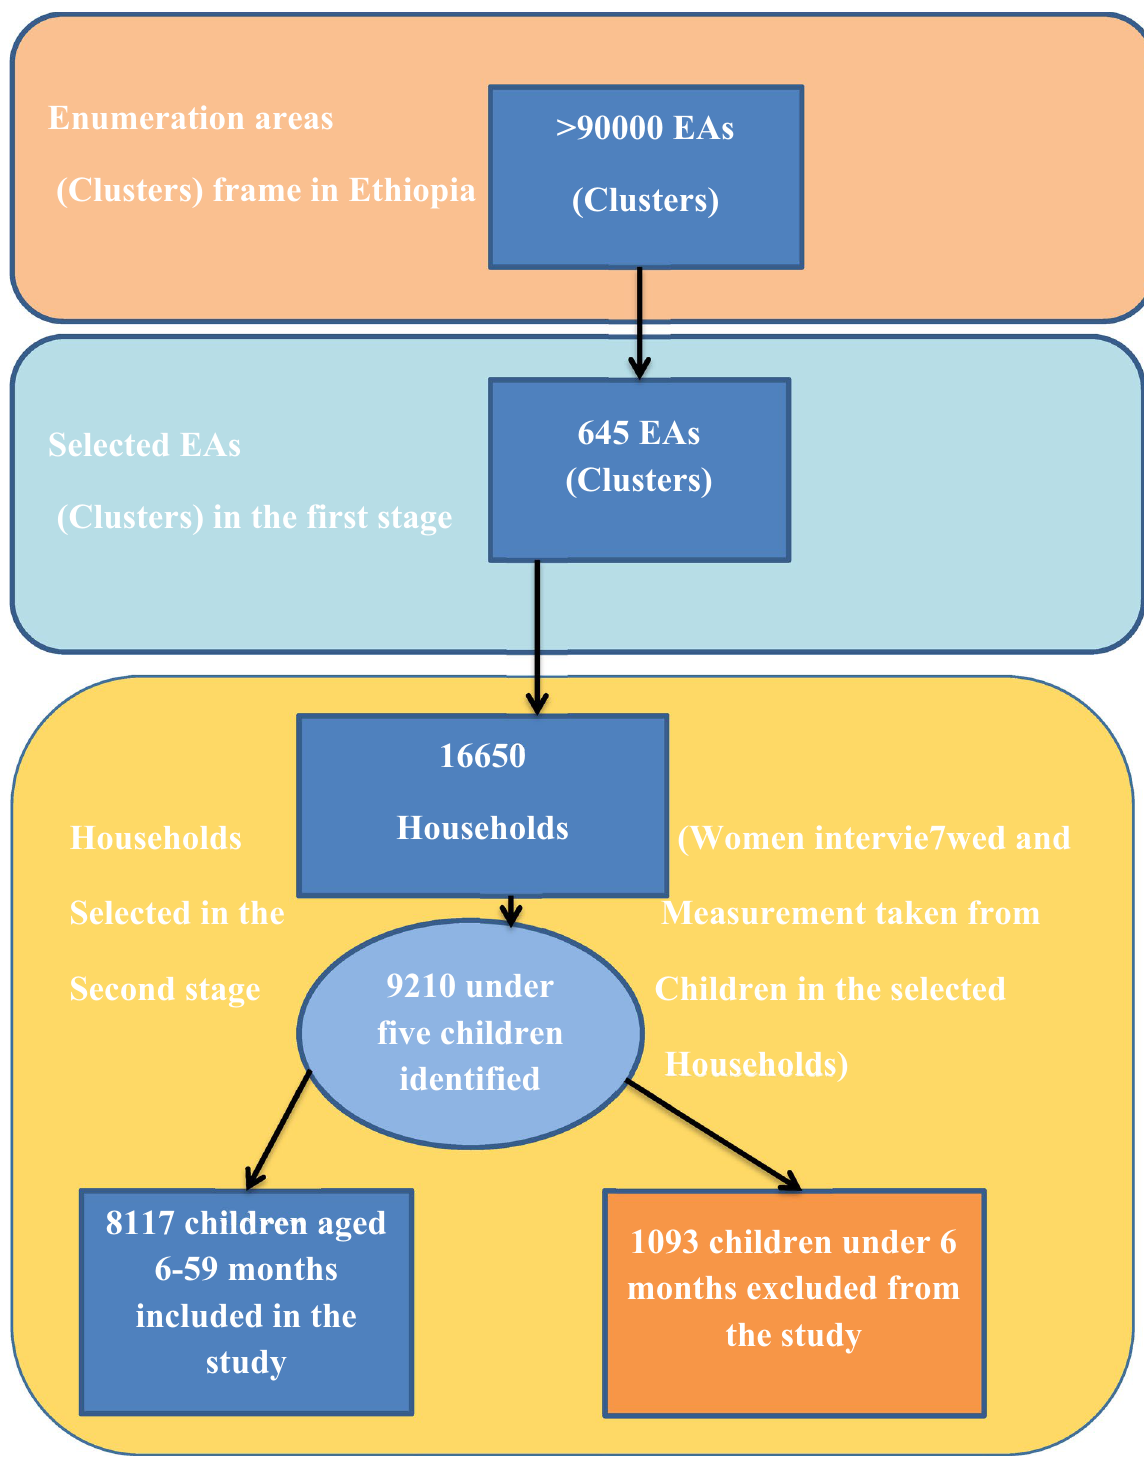
Figure 1. The sampling procedure of the study predictors of stunting among children aged 6–59 months in Ethiopia (n =